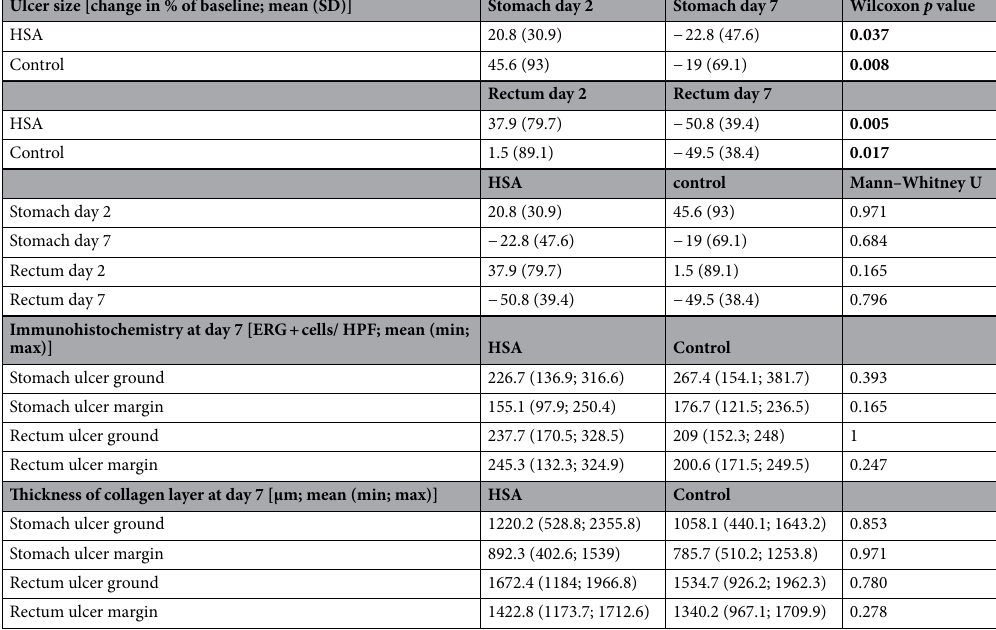
Table 1. Comparison of changes in ulcer size after 2 and 7 days (end of study), immune-histochemical studies, and thickness of collagen layer at day 7 between HS-treated and non-treated pigs. Wilcoxon’s test and Mann– Whitney U test were used for statistical analyses. Significant results are printed in bold. ERG member of the ETS family of transcription factor, HPF high power field, HSA Hemospray application, SD standard deviation.